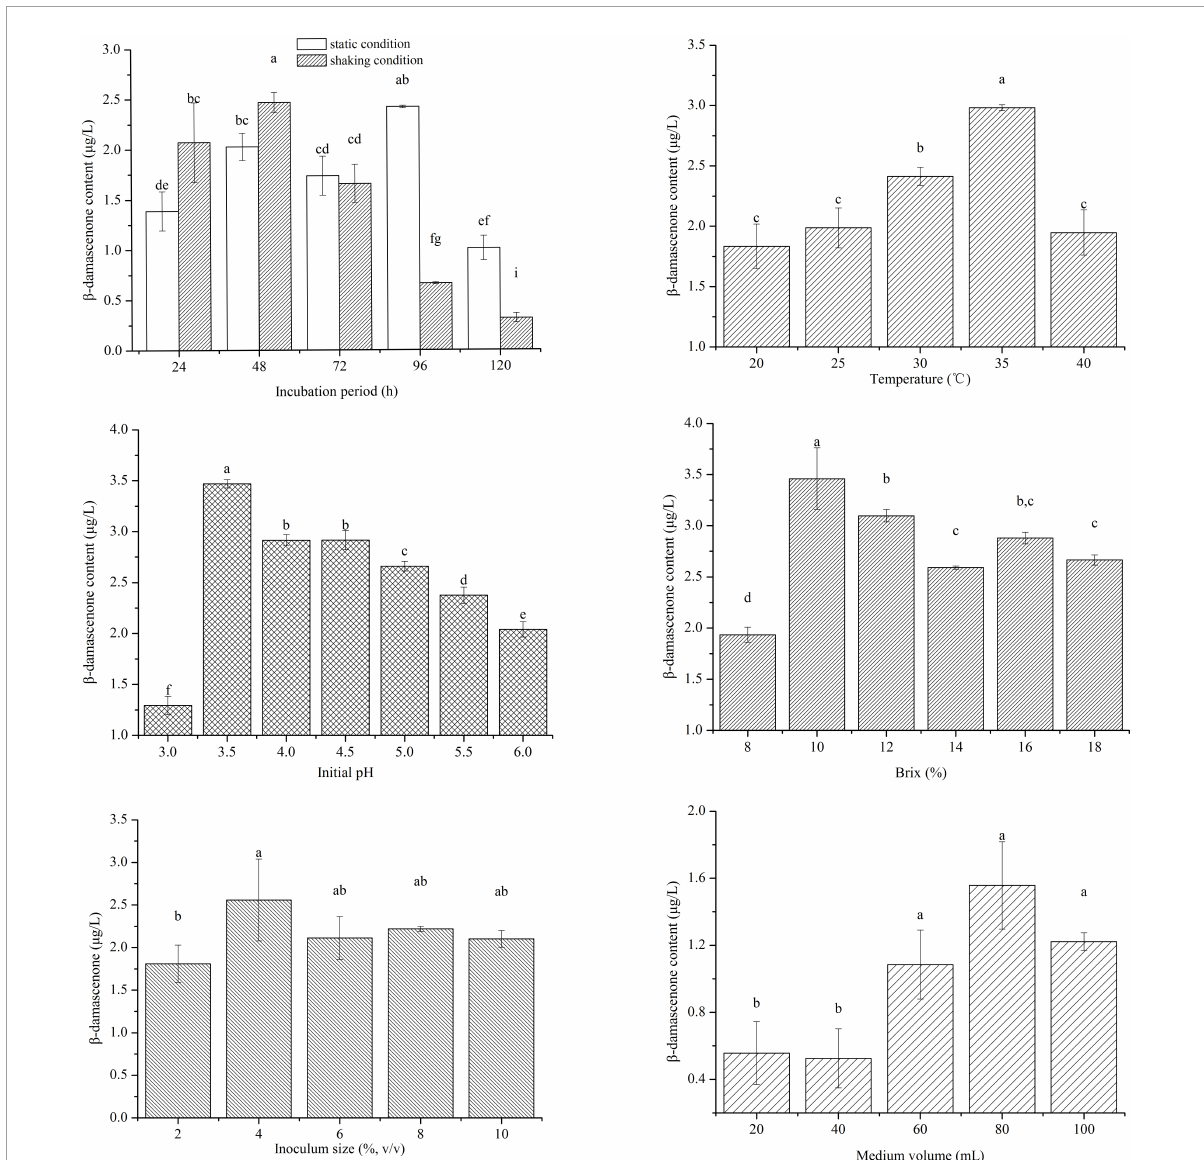
FIGURE3 Effect of culture conditions on β -damascenone production by one-factor-at-a-time (OFAT). Values marked with the same lowercase letters represent no significant difference ( p < 0.05, Duncan’s